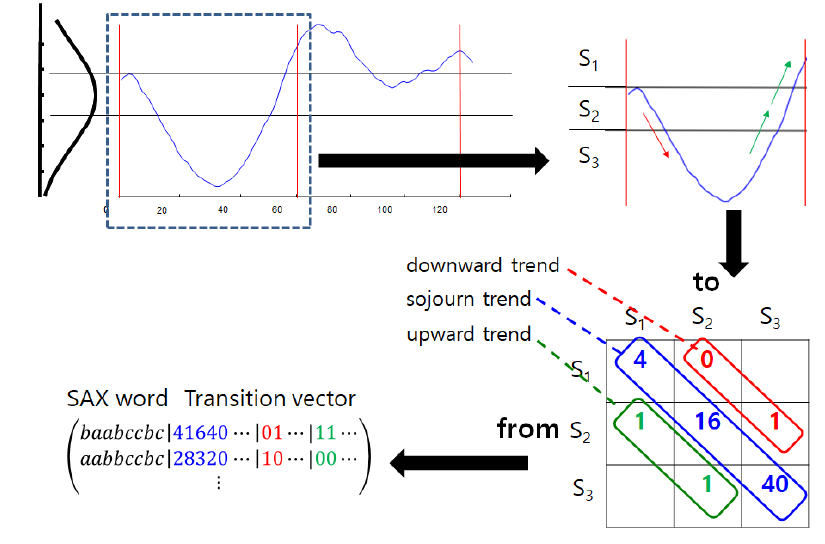
Figure 1. Graphical description of transitional